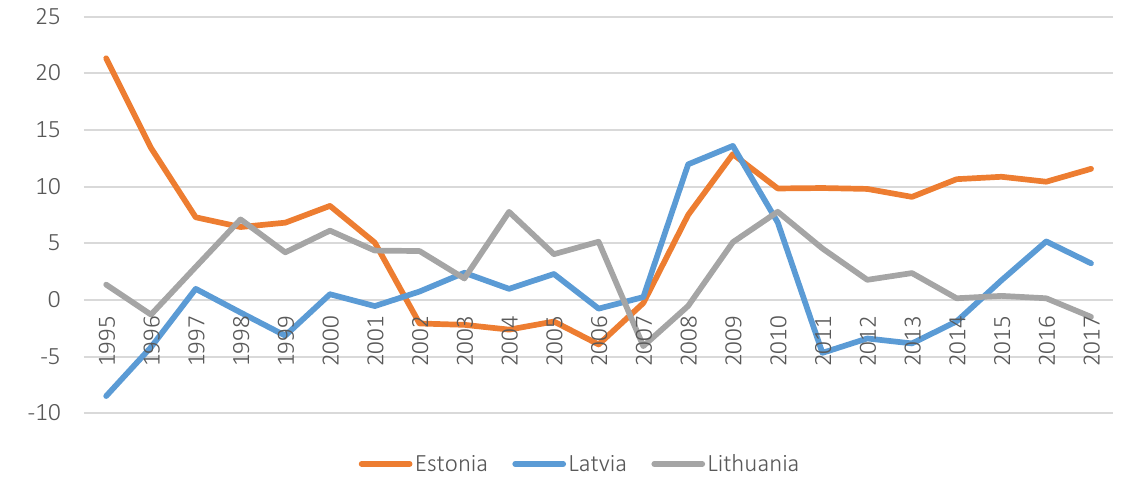
Figure 3. The household saving rate in the Baltics, % of disposable